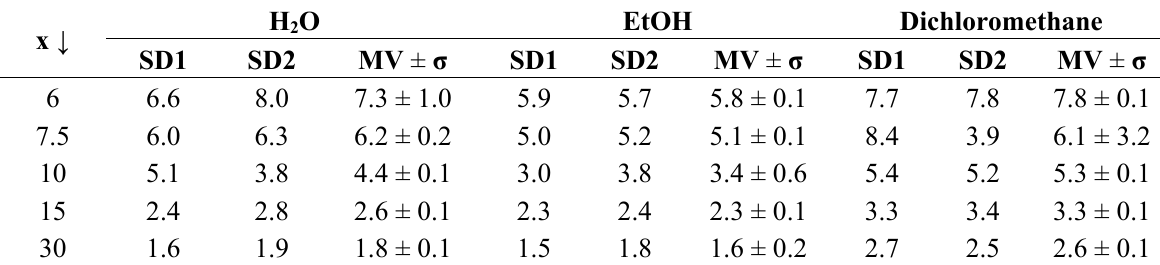
-p TMBO networks in water, ethanol, and 150 x − m )/ m were determined swollen dry dry